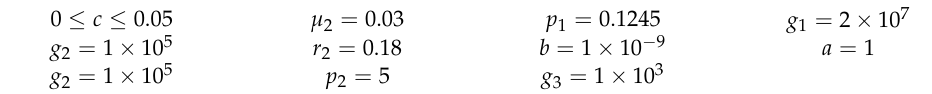
Table 1. Parameter values.